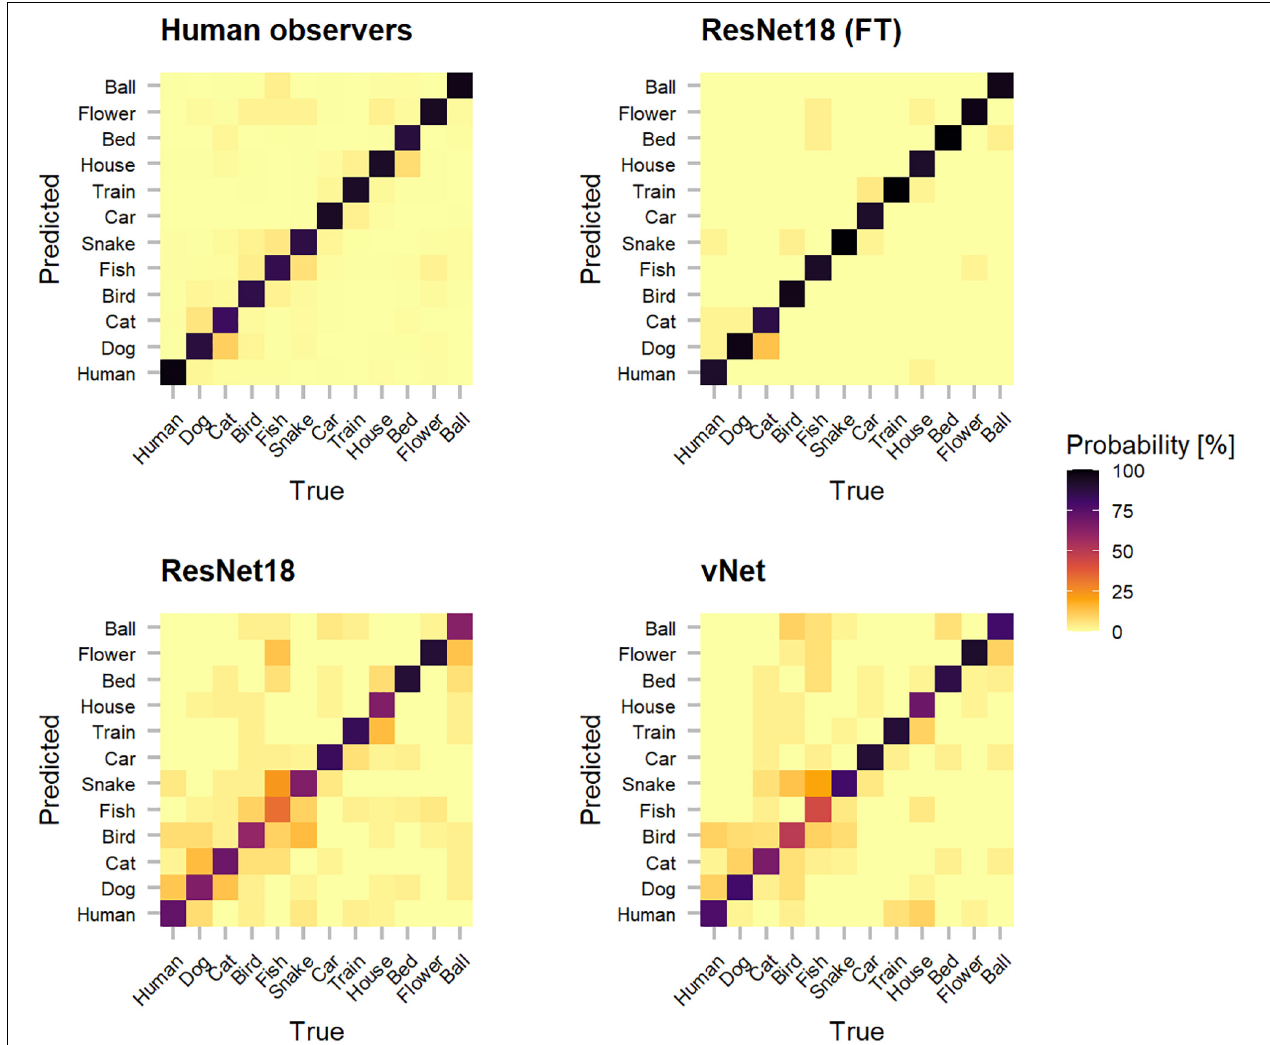
FIGURE 5 | Categorization matrices reveal the classification patterns of true vs. predicted labels that underly raw object recognition performances and thereby help to understand especially classification errors. The off-diagonal misclassifications show that human observers seemed to have problems with conceptually similar classes (such as dog and cat or fish and snake). Interestingly, especially both trained-from-scratch ResNet18 and vNet made similar